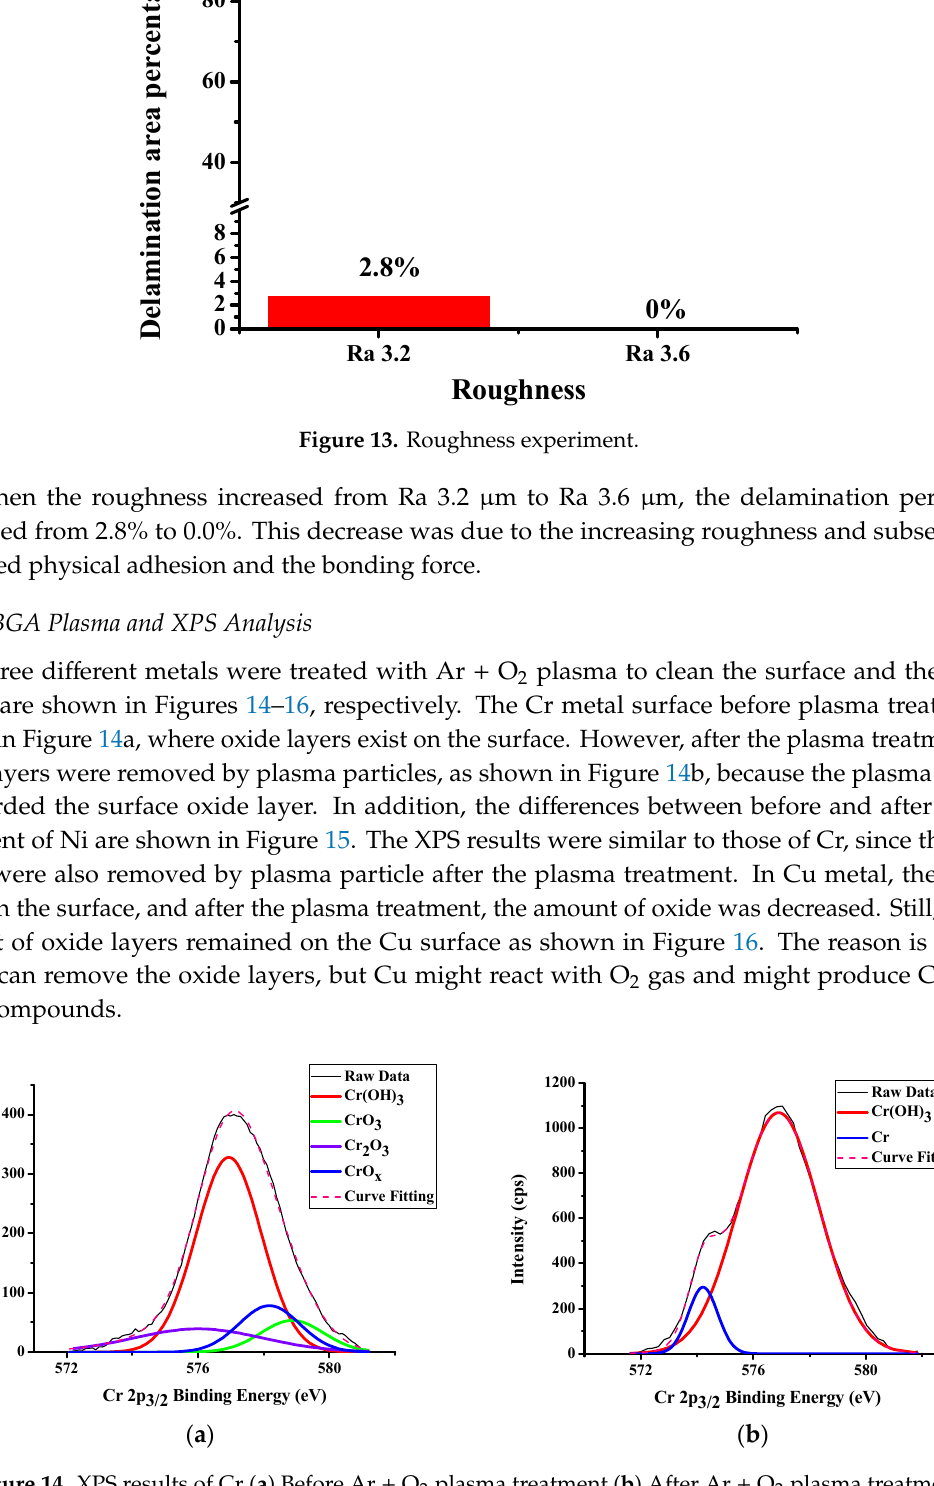
Figure 14. XPS results of Cr ( a ) Before Ar + O 2 plasma treatment ( b ) After Ar + O 2 plasma treatment.